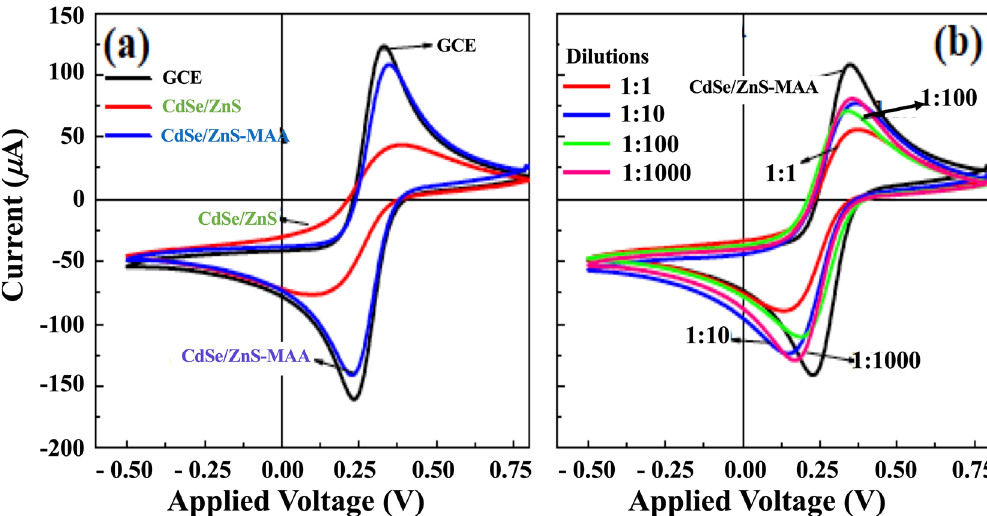
Figure 3. ( a ) CV scans of bare electrode (black), QDs (red) and MAA-QDs (blue) modified GC electrodes. ( b ) Variation in the CV of MAA-QDs (black) after conjugation with different dilutions of COx: 1:1 (red), 1:10 (blue), 1:100 (green), and 1:1000 dilution (pink) COx conjugated